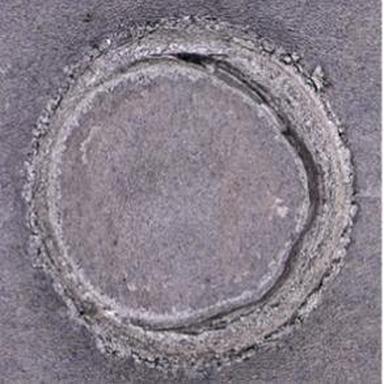
Post-failure macro-images of Usibor® 1500-AS and Ductibor® 1000-AS spot welds under shear and normal loading.